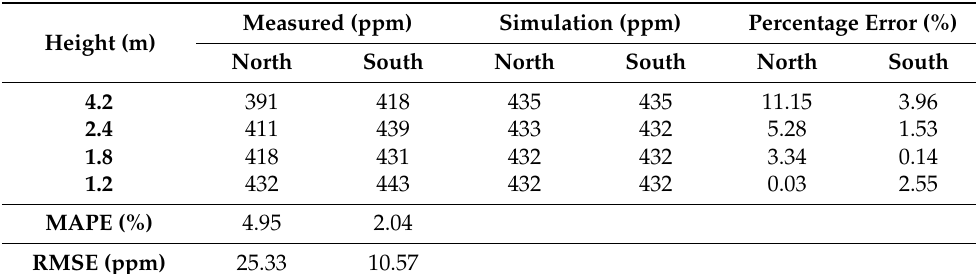
Table 4. Comparison of CO 2 concentration between measured and simulated data for model valida- tion in greenhouse.